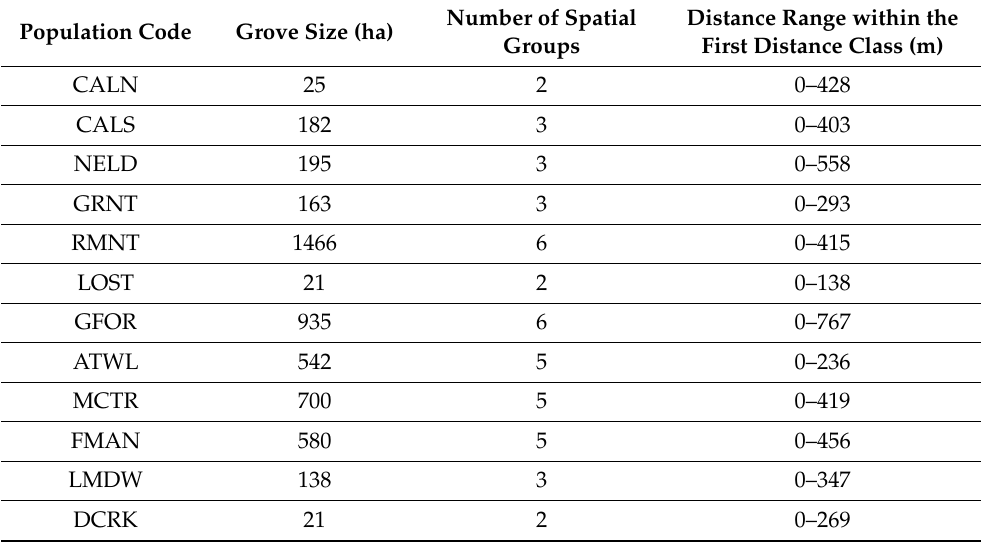
Table A2. Grove size, number of spatial groups, and distance within the first distance class for populations analyzed with